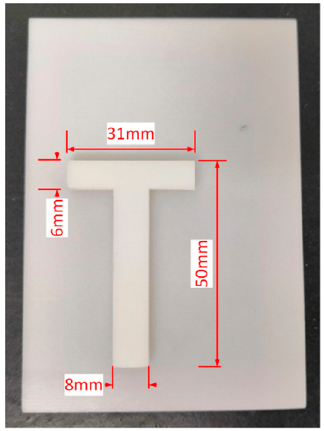
Figure 12. 3D-printed “T” shape imaging target.